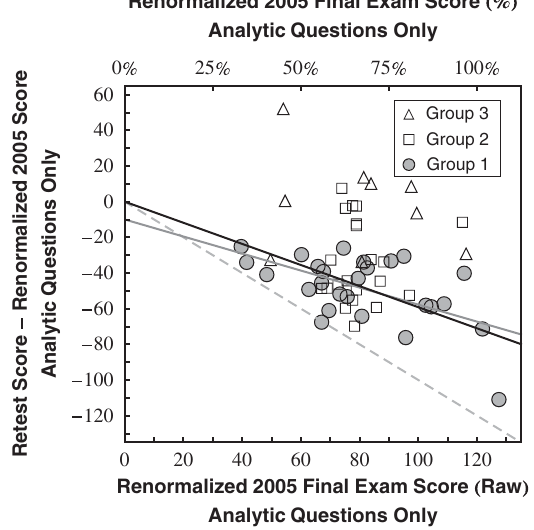
FIG. 2. Score shift between the end of freshman mechanics and the end of senior year on analytic problems versus freshman performance. The dotted line is the boundary corresponding to a score of zero on the retest. The solid lines are fits to the group 1 data only (gray with floating intercept, black with x intercept fixed at zero). The floating fit has x intercept (cid:4) 10 : 0 (cid:5) 11 : 9 , which is consistent with zero. The slope of the fixed fit indicates knowledge loss of 0 : 59 (cid:5) 0 : 04 in the seven semesters since taking